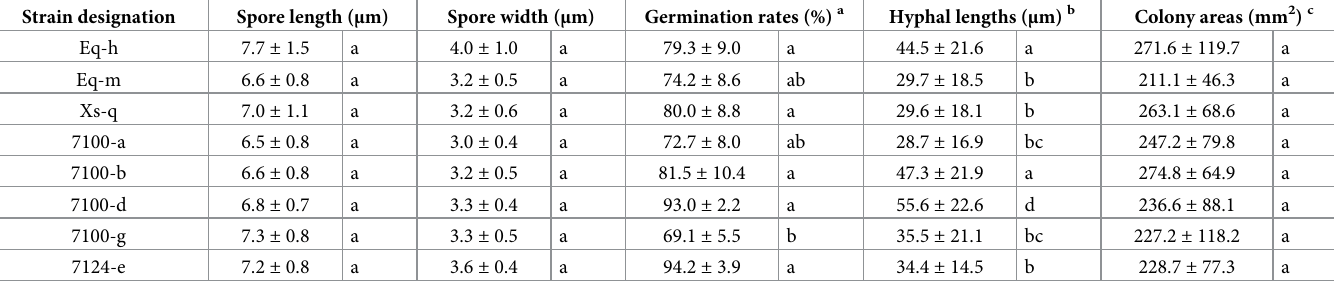
Table 2. Morphological characteristics of Ampelomyces spp. fungi subcultured on Czapex-Dox agar medium supplemented with 2% malt (MCzA). Strain